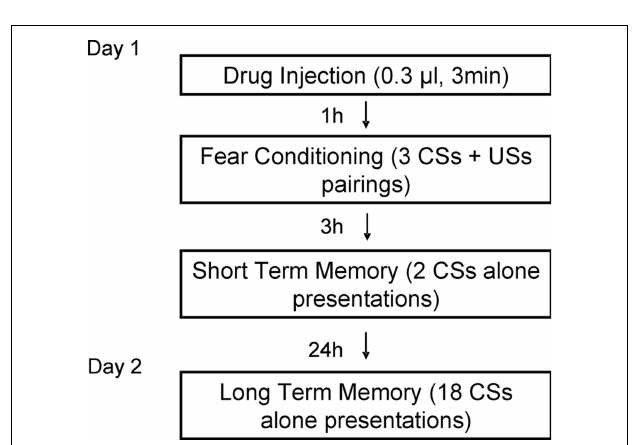
35.6 ± 7.3% ( p < 0.05). Muscimol signifi cantly increased the PPD ratio and of IPSCs by 42.5 ± 5.2% ( p < 0.05) and increased the PPF ratio of EPSCs by 39.2 ± 3.9% ( p < 0.05).